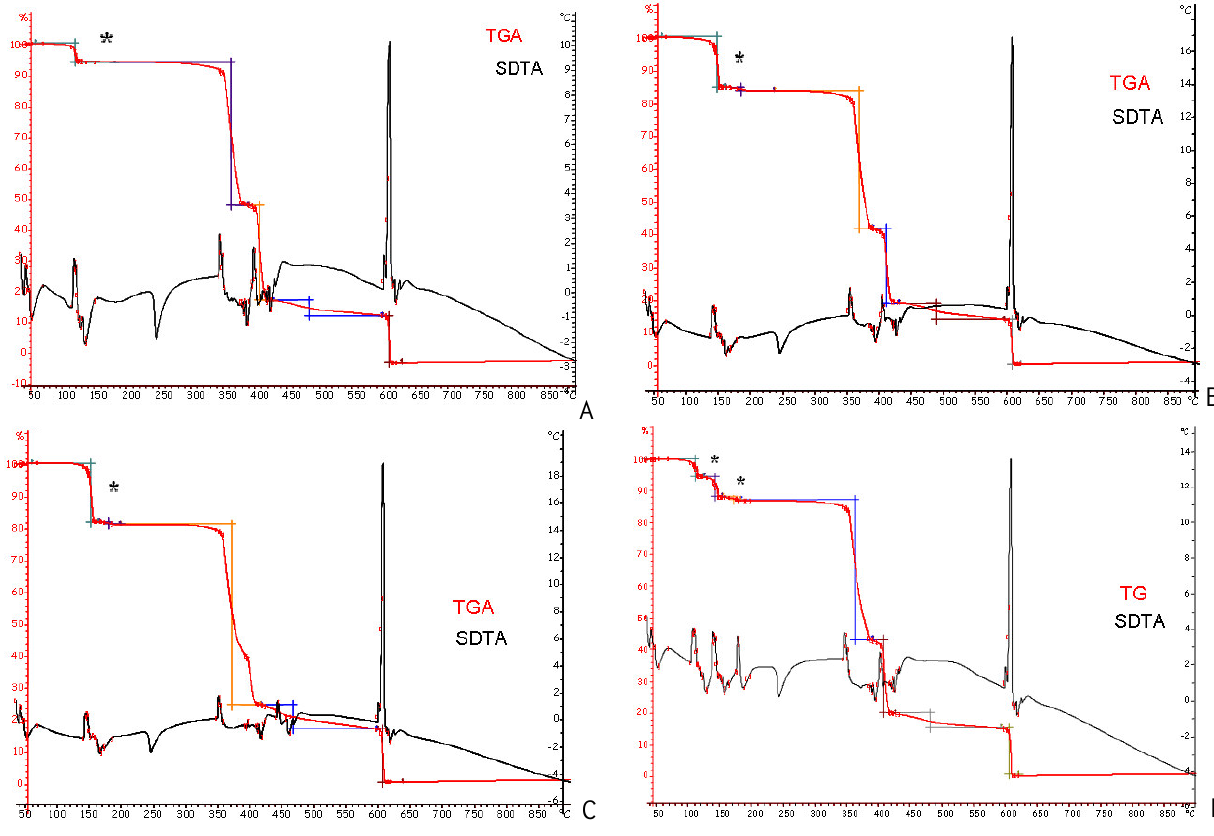
Figure 3 . TG and STDA analysis of 1 ·0.5 AC (clathrate A); 1 ·DMSO (clathrate B); 1 ·0.9 NMP